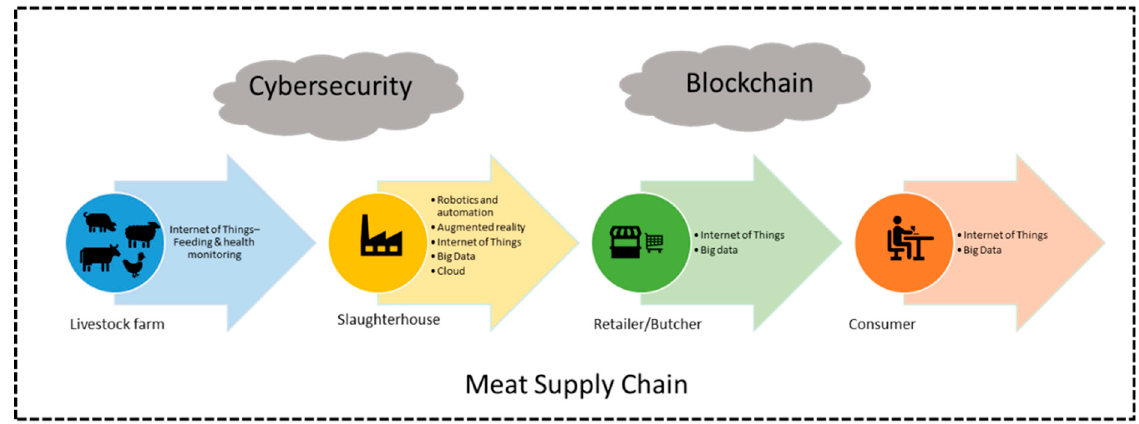
Figure 2. Meat 4.0—Application of Industry 4.0 technologies in the meat supply chain.